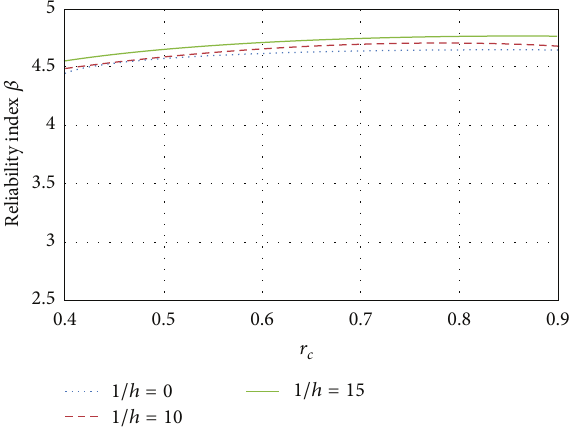
Figure 12: Influence of the slenderness; 𝑒 = 𝑒 𝑏